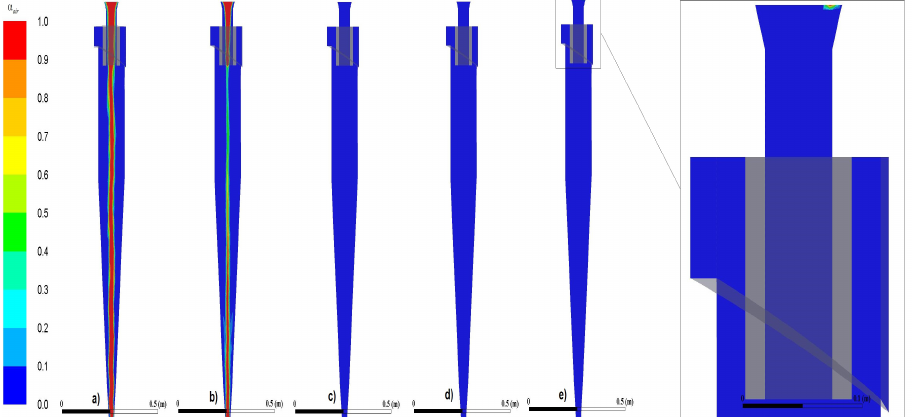
Figure 7. Contours coloured by volume fraction of air from the VOF-DEM model at flow-time after injection of particles: ( a ) 0 s, ( b ) 1 s, ( c ) 2 s, ( d ) 3 s and ( e ) 4 s.